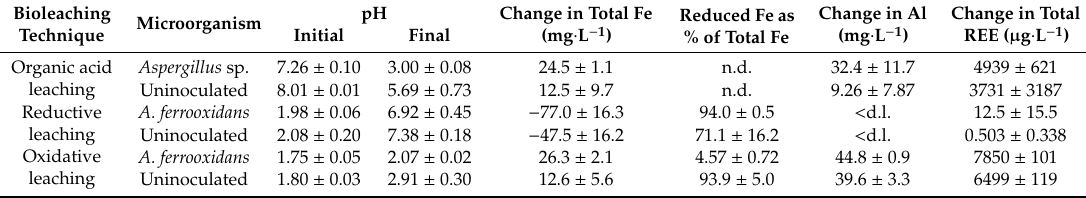
Table 8. Changes in pH, iron, aluminium and TREE concentrations and percentage of reduced iron in final solutions for clay-rich bauxite during organic acid, reductive and oxidative leaching and uninoculated controls, recorded after 1 h and then at the end of 7 days of leaching. The initial pH for reductive and oxidative leaching was measured after the addition of H 2 SO 4 . This was required in order to reduce the pH to within the growth range for A. ferrooxidans , following pH increase caused by carbonate dissolution. Characterisation of starting fluid conditions is shown in Table 3. Errors are one standard deviation of triplicate